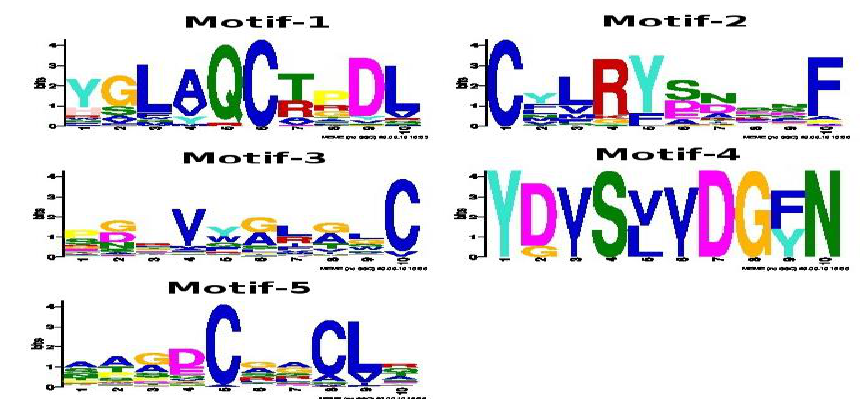
Figure 3: The identified protein domains / motifs in predicated wheat